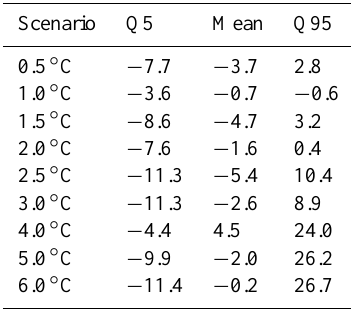
Table 2. Percent change in Pakse (Mekong 2) annual mean, Q5 and Q95 discharges for 0.5–6 ◦ C increases in global mean temperature using HadCM3.